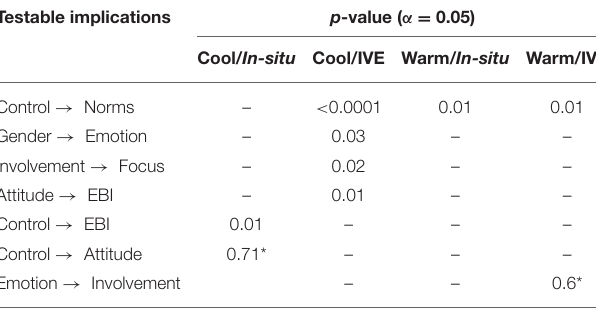
TABLE 5 | Cross-validation results of the hypothesis tests in EBI